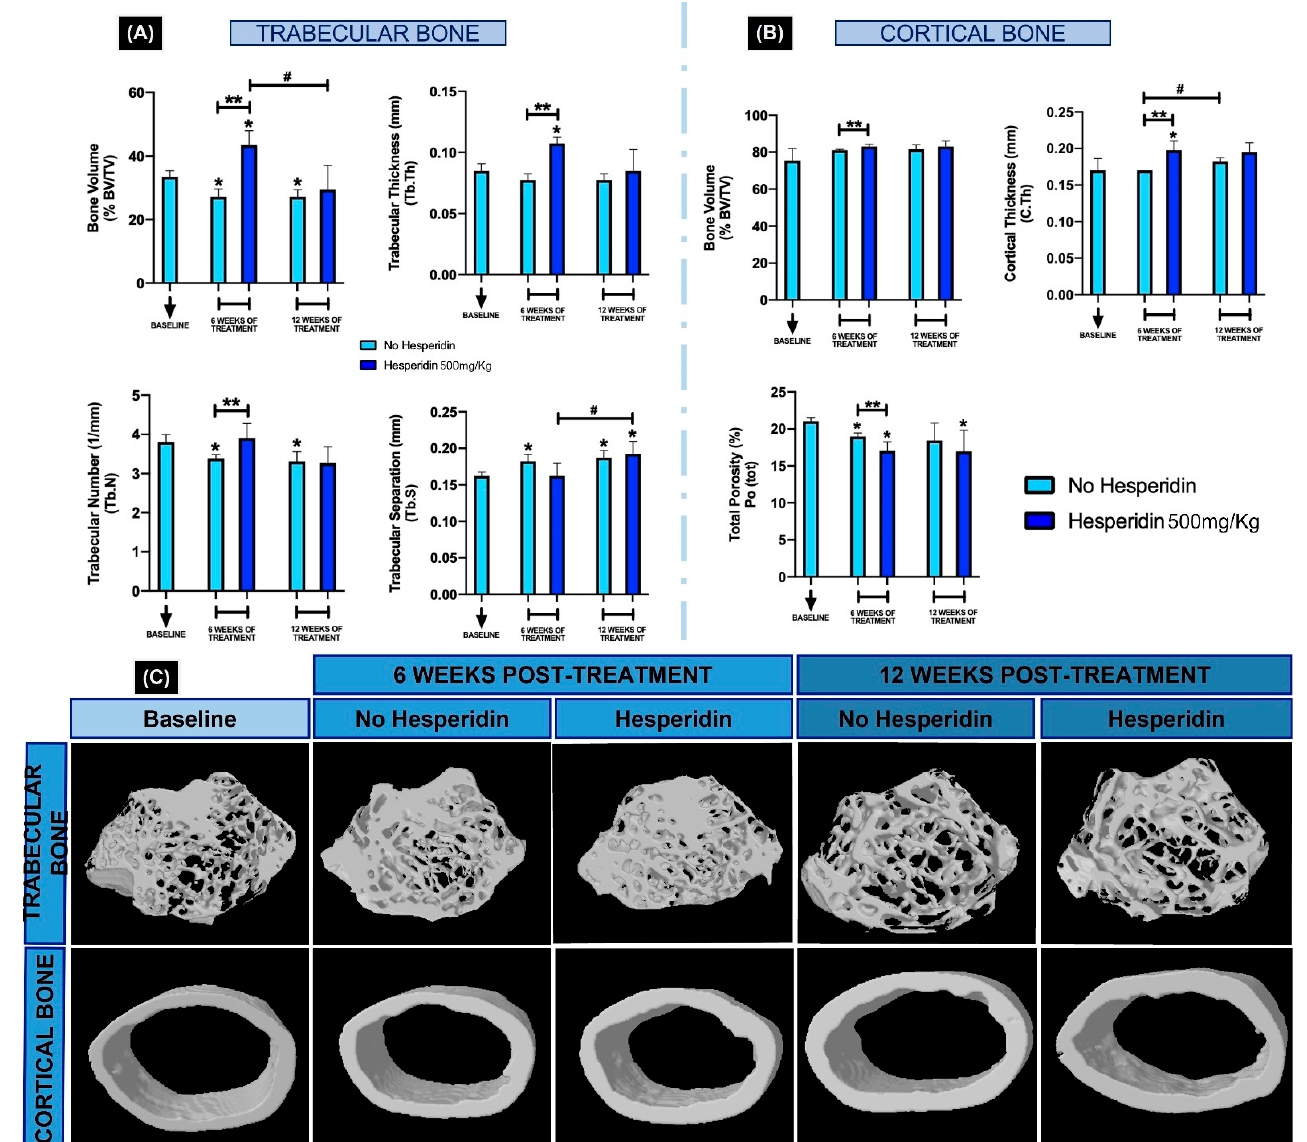
Figure 6. Microcomputed tomographic evaluation of femoral bone at baseline, 6 and 12 weeks post-hesperidin treatment. The microarchitecture parameters of trabecular ( A ) and cortical bone ( B ) evaluated were bone volume fraction (BV/TV, %), trabecular thickness (Tb.Th), trabecular number (Tb.N), trabecular separation (Tb.S), cortical thickness (C.Th) and cortical total porosity (Po.tot). Systemic hesperidin treatment increased BV/TV in both trabecular and cortical bone at 6 weeks, but the difference to no hesperidin was not maintained at 12 weeks. In ( C ), 3D reconstructed models of femurs show trabecular and cortical representative images per group. * p < 0.05 compared to the baseline group. ** p <0.05 comparison between hesperidin and no hesperidin at the 6-week time point. # p < 0.05 comparing between 6 and 12 weeks.